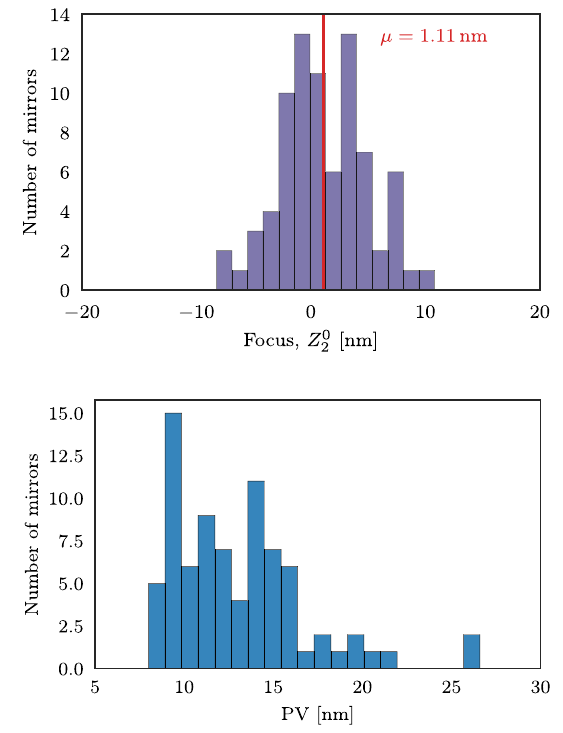
4.FIG. 7. (Top) distribution of the Zernike Coefficient Z 0 2 (focus)